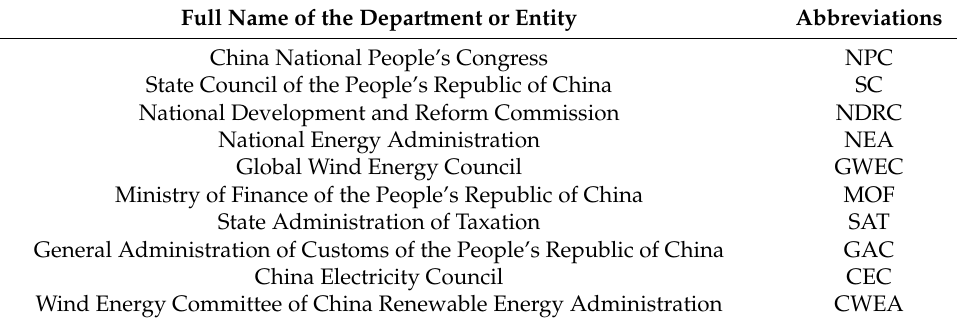
Table 1. The abbreviations of departments or organizations.